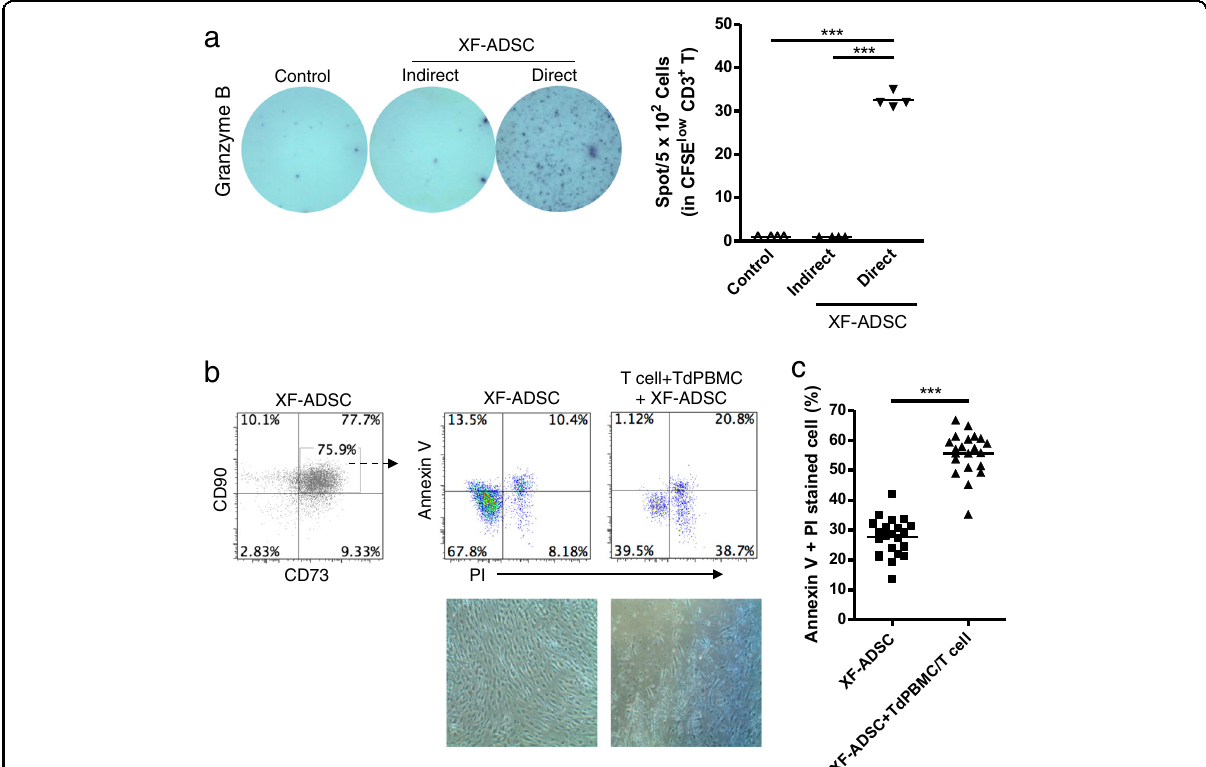
Fig. 4 Adipose-derived mesenchymal stem cells grown in xeno-free medium (XF-ADSCs) cause delayed T cell-mediated cytotoxicity through a direct pathway. a Comparison of antigen recognition through direct and indirect pathways in allogeneic antigen stimulation, as described for the enzyme-linked immunospot (ELISPOT) analysis in the Materials and methods. Spots of granzyme B secreted by CD3 T cells were analyzed by ELISPOT analysis ( n = 4 for each sample). b XF-ADSCs were subjected to allogeneic antigen stimulation for 21 – 24 days in xeno-free medium containing 5% autologous serum. For cell death analysis, the collected XF-ADSCs were stained with anti-CD73 and anti-CD90 antibodies, annexin V, and propidium iodide (PI). The rate of XF-ADSC death induced by T cells was compared with that of control XF-ADSCs not containing recipient immune cells after analysis by fl ow cytometry. c Graphical representation of XF-ADSC death corresponding to ( b ) ( n = 22 for each sample); *** p < 0.001. Td-PBMCs T cell-depleted T cell-depleted peripheral blood mononuclear